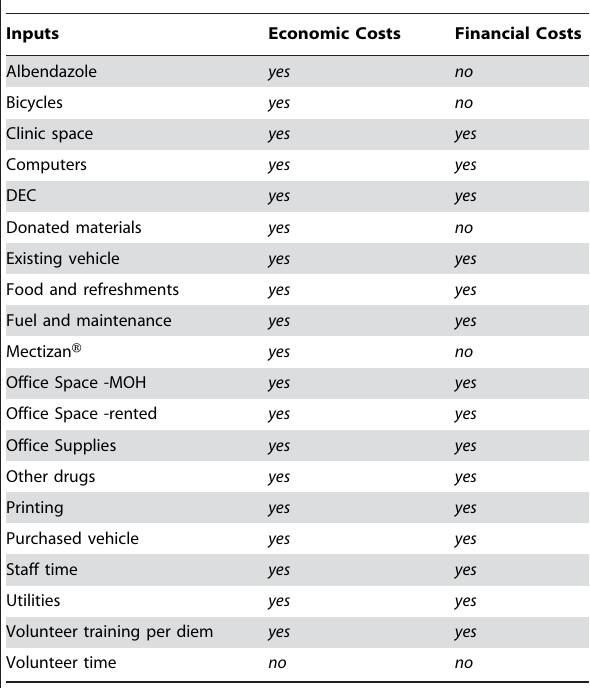
Table 1. Classification of